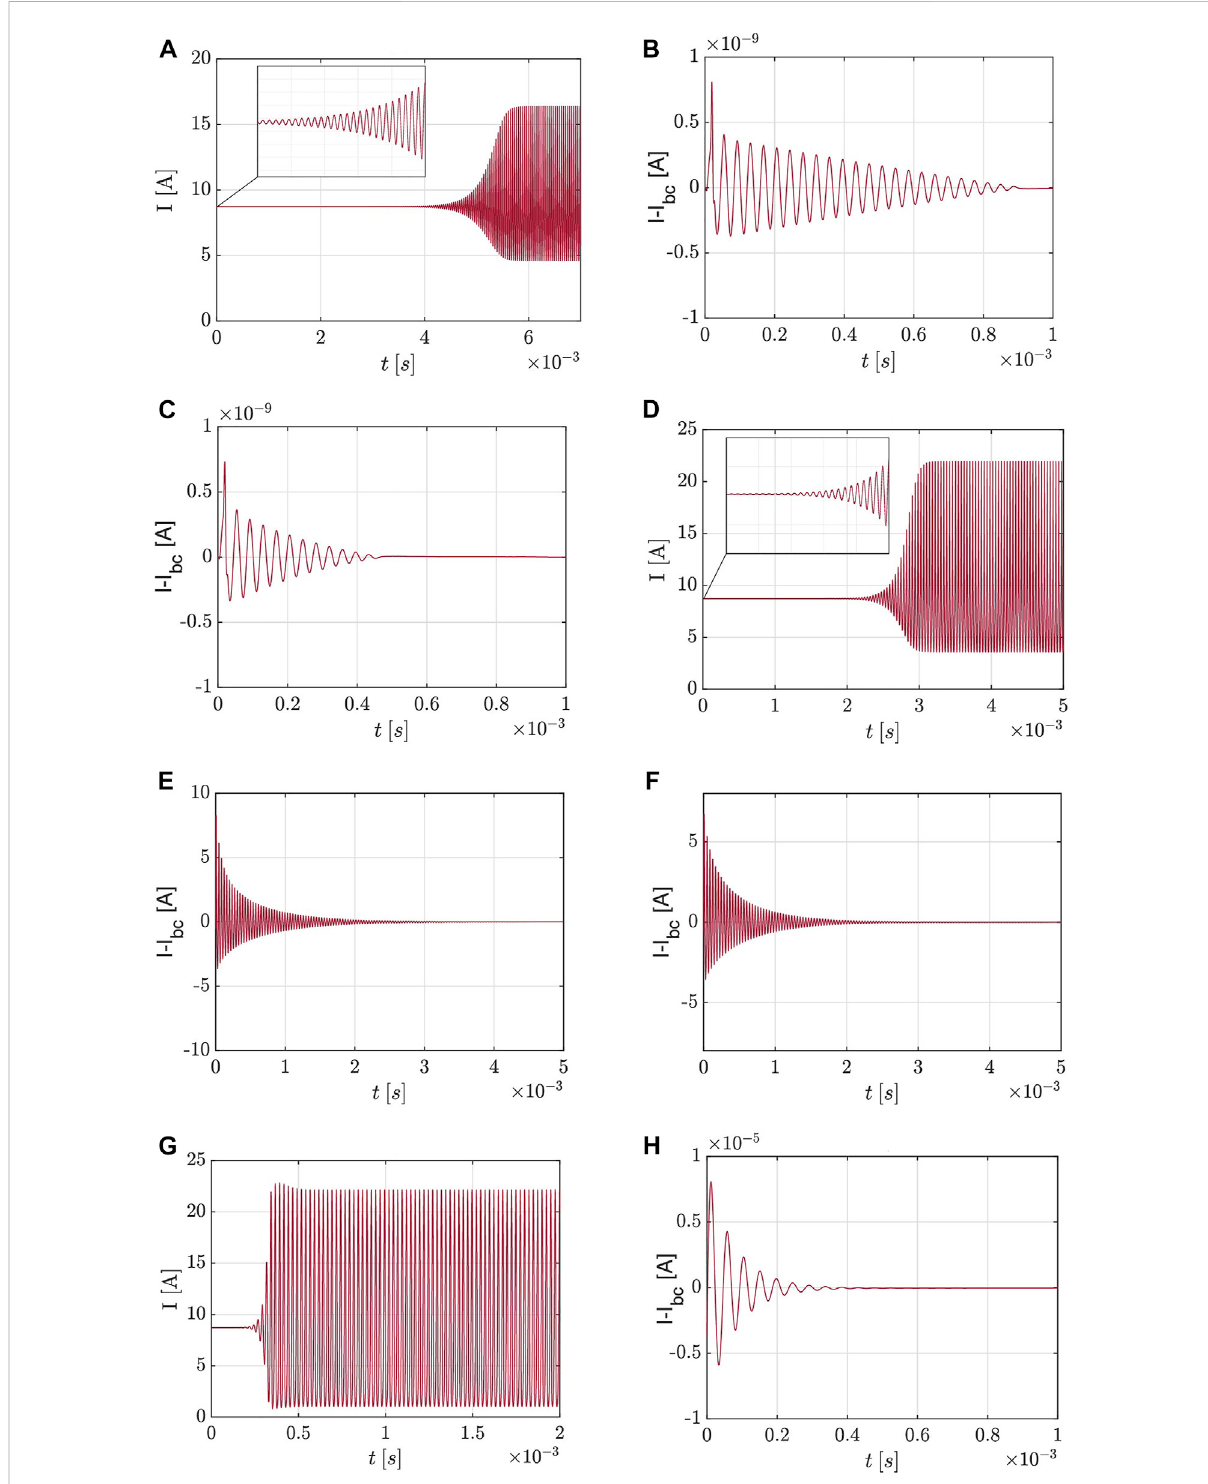
FIGURE 2 Simulateddischargecurrentsignalfortests (A) T1, (B) T2, (C) T3 (D) T4startingfromaperturbationofthebasecon fi gurationandtests (E) T2and (F) T3 starting from the saturated breathing instability; results from tests T6 and T7 are reported in (G) and (H) ,